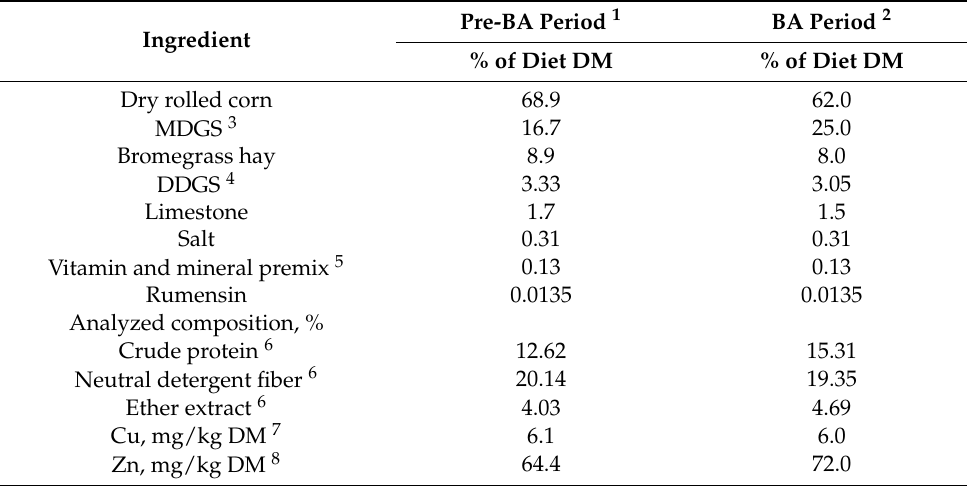
Table 1. Ingredient and composition analysis of non-copper-supplemented diet in pre-beta agonist (BA) and BA